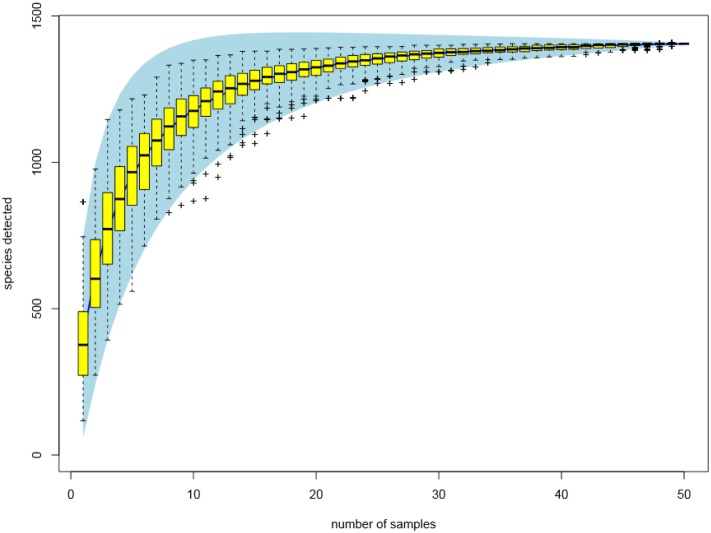
Rarefaction curves of all the fecal samples (n = 50) clustered at 97% sequences identity.